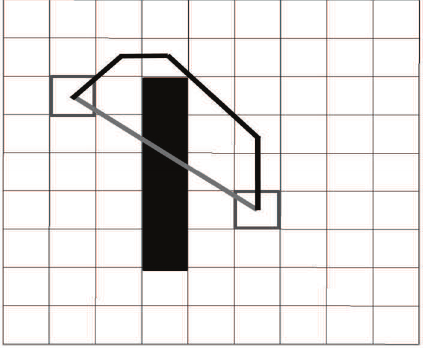
Figure 4: The difference between Manhattan shortest distance and Euclidean shortest